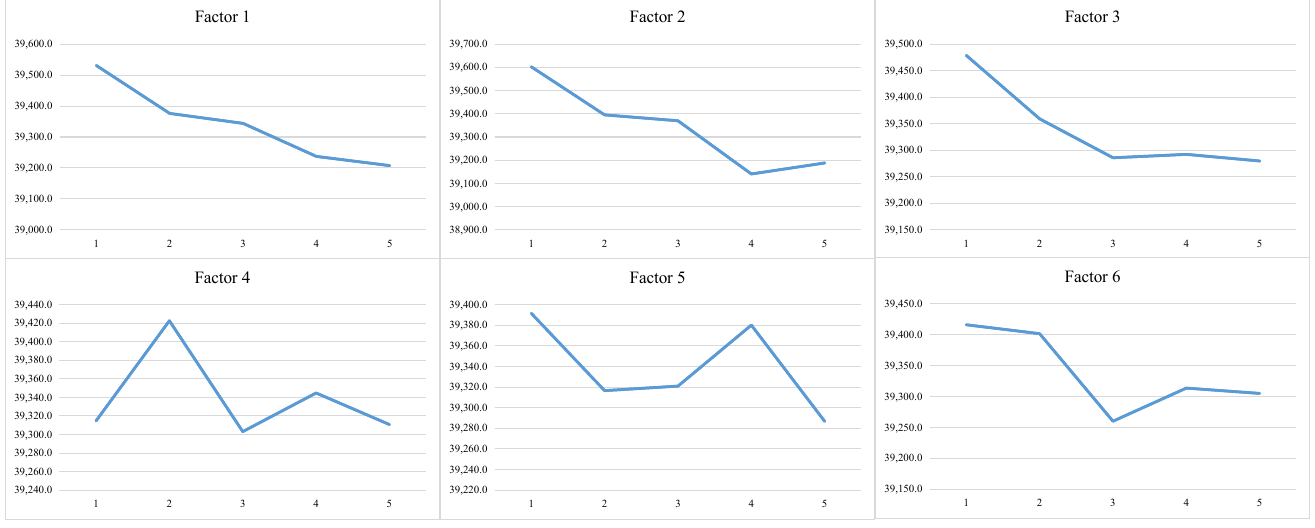
Figure 7. Factor level trend of